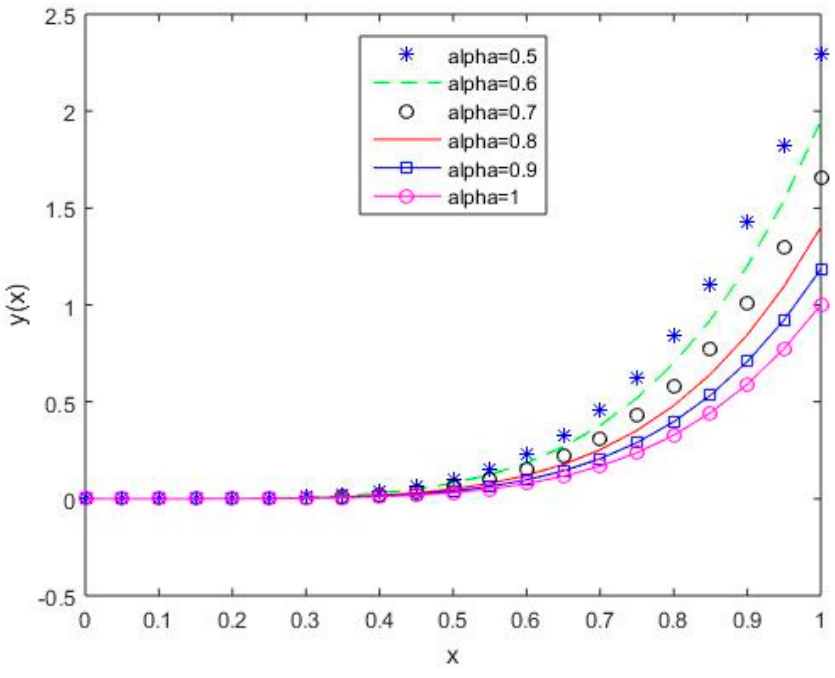
Figure 10. The behavior of solutions using S5 for α values of 0.5, 0.6, 0.7, 0.8, 0.9, and 1, Example 1.